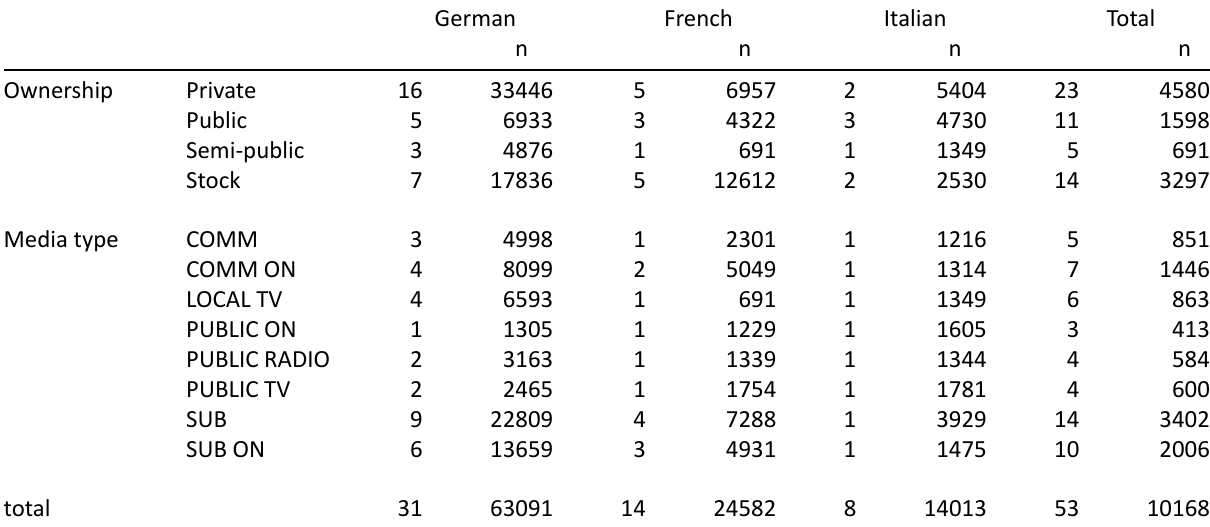
Table 1. Media sample: Number of outlets and news items